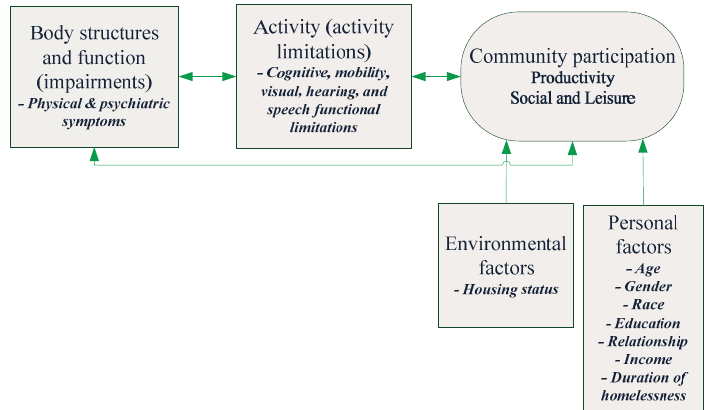
Figure 1. Model of potential factors related to community participation for people who have experienced